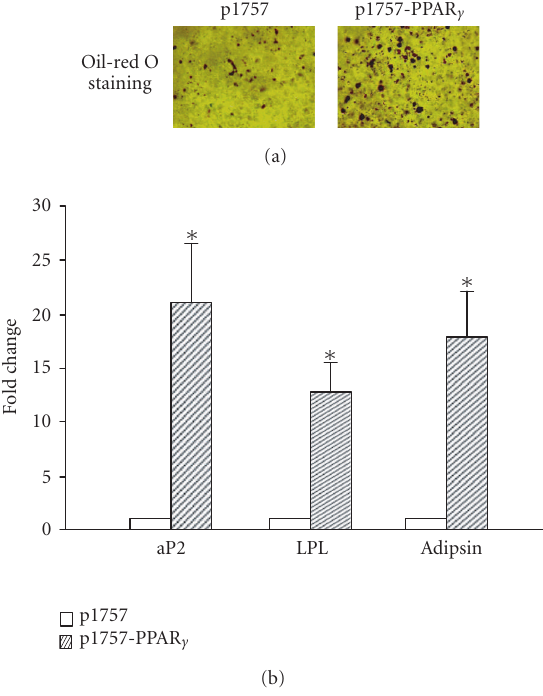
Figure 3: Adipogenic changes in the growth plate chondrocytes transfected with a PPAR γ plasmid under the control of a collagen α 1(II) promoter. (a) Growth plate cells were transfected with the p1757-PPAR γ plasmid. Transfected cells were maintained in pellet cultures for 10 days, followed by Oil Red-O staining. (b) Quantitative PCR analysis of adipogenic markers of the p1757-PPAR γ transfected growth plate cells at day 4 after transfection. Cells transfected with the empty p1757 plasmid were used as controls. Gene expression levels were normalized with respect to endogenous 18S rRNA. ∗ P < . 05 versus the expression in control